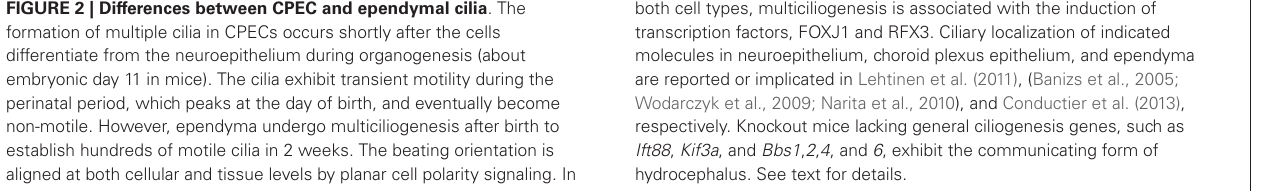
both cell types, multiciliogenesis is associated with the induction of transcription factors, FOXJ1 and RFX3. Ciliary localization of indicated molecules in neuroepithelium, choroid plexus epithelium, and ependyma are reported or implicated in Lehtinen et al. (2011), (Banizs et al., 2005; Wodarczyk et al., 2009; Narita et al., 2010), and Conductier et al. (2013), respectively. Knockout mice lacking general ciliogenesis genes, such as Ift88 , Kif3a , and Bbs1 , 2 , 4 , and 6 , exhibit the communicating form of hydrocephalus. See text for